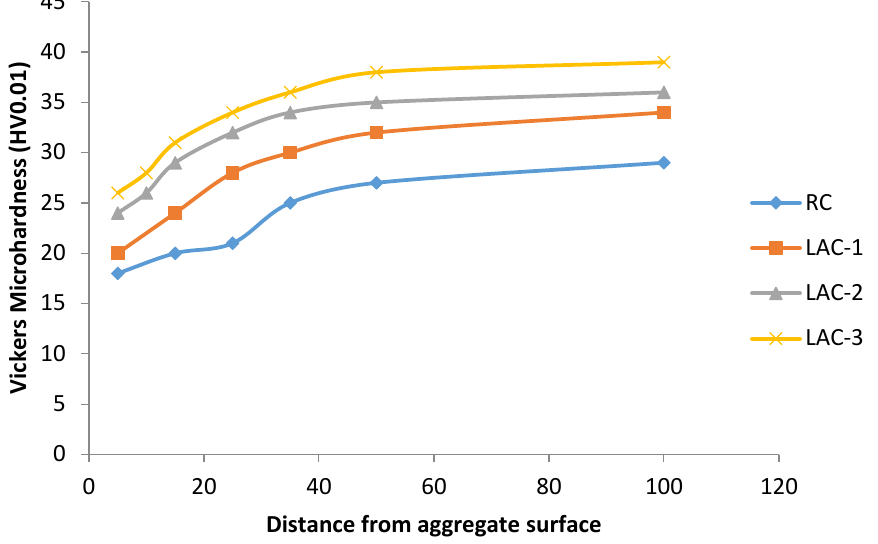
Figure 7. Micro-hardness values of the ITZs of the mixes.